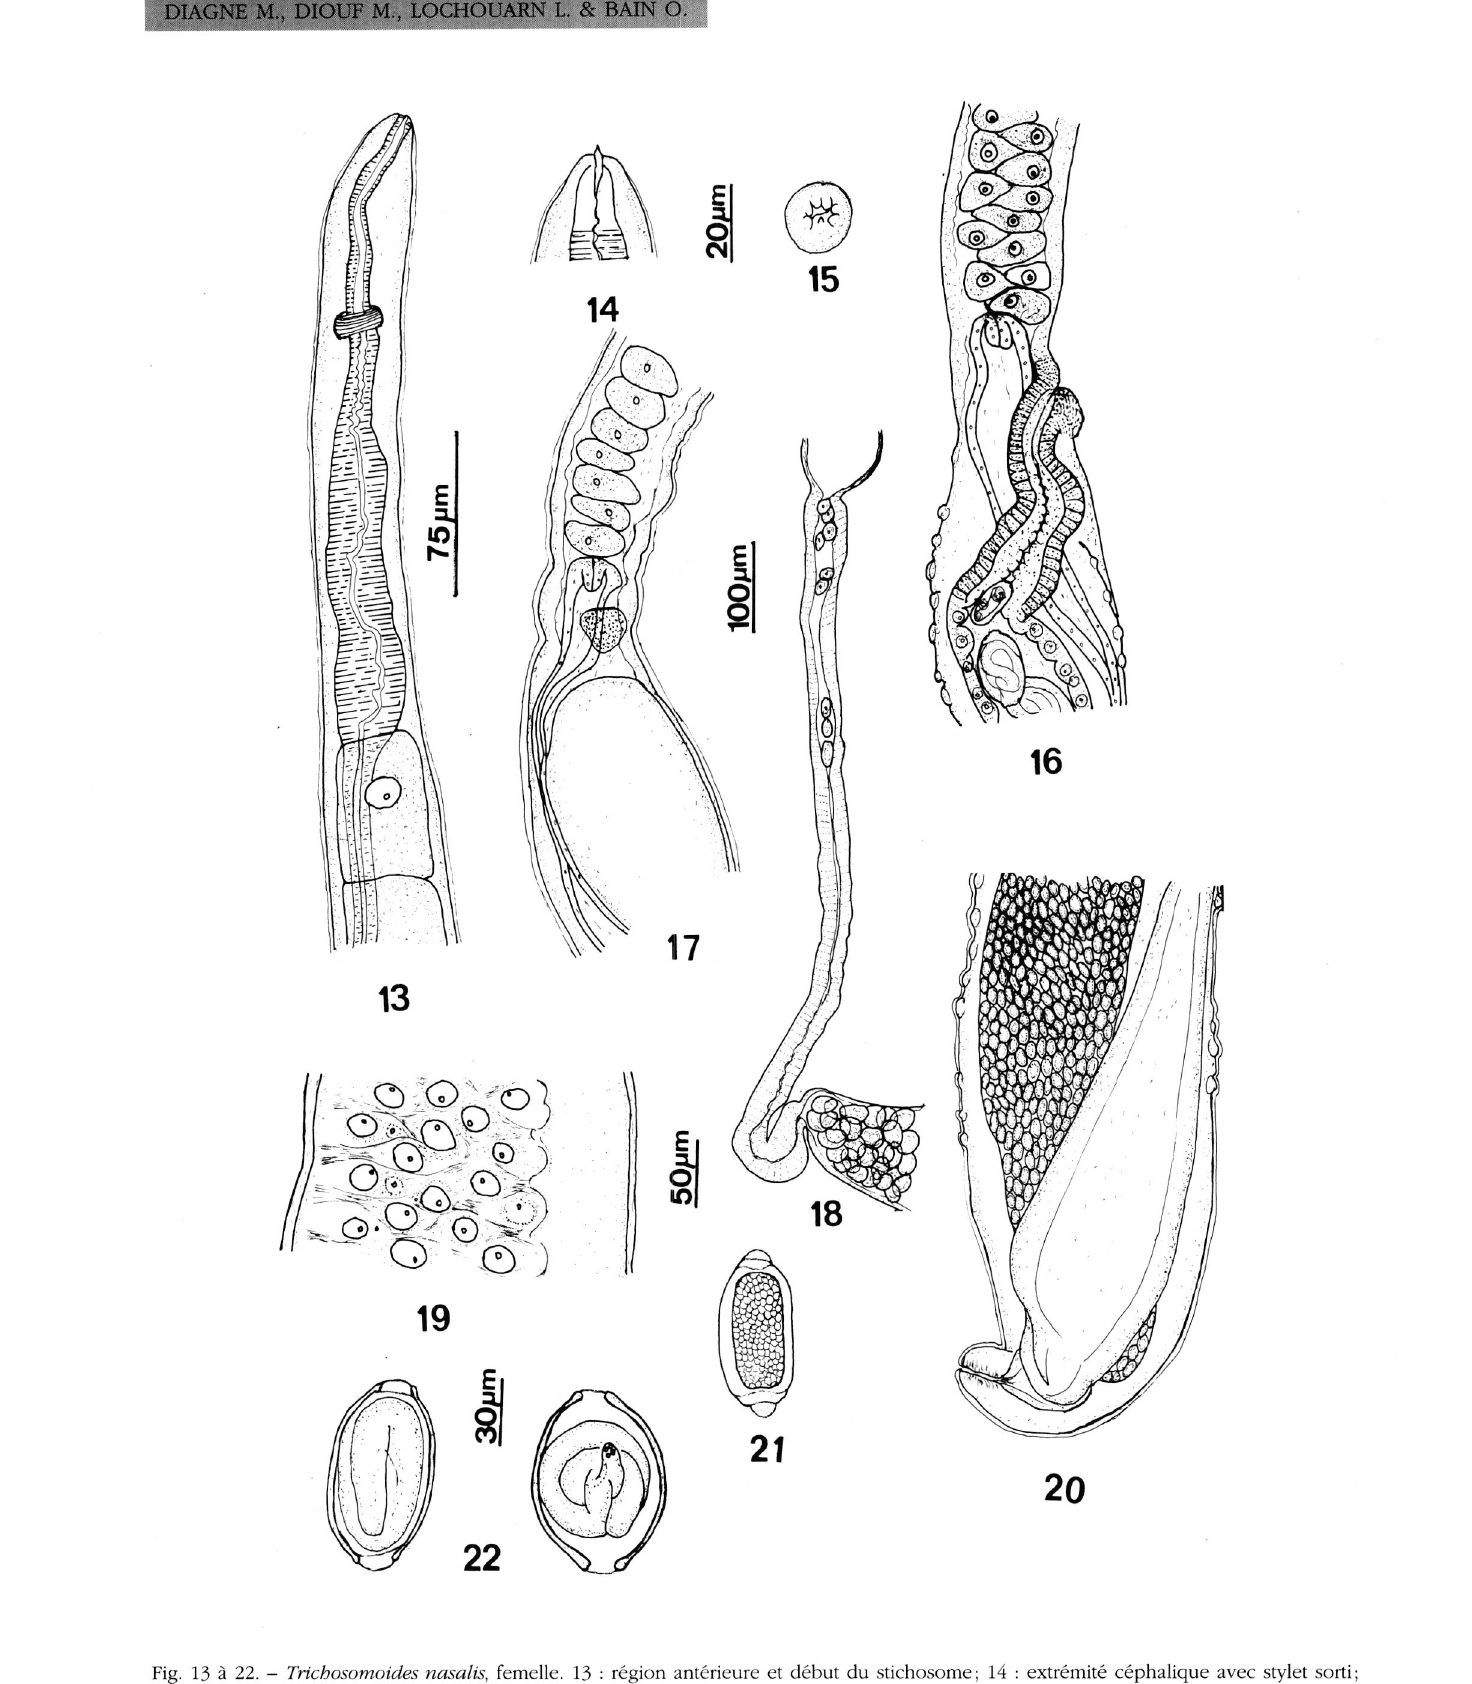
Fig. 13 à 22. - Trichosomoides nasalis, femelle. 13 : région antérieure et début du stichosome; 14 : extrémité céphalique avec stylet sorti; 15 : tête, vue apicale; 16 : région vulvaire et jonction œsophage-intestin (mamelons des bandes bacillaires visibles en vue latérale); 17 : idem, vue ventrale (noter le relief post-vulvaire presque sphérique); 18 : oviducte et début de l'utérus; 19 : une bande bacillaire à mi- corps ; 20 : région postérieure, montrant l'intestin plat et large et le rectum court; 21 : œuf immature aux bouchons saillants; 22 : œuf embryonné intra-utérin, vu de profil et de face. Échelles : 13, 75 pm ; 14, 15, 20 pm ; 16, 17, 18, 20, 100 pm ; 19, 50 pm ; 21, 22, 30